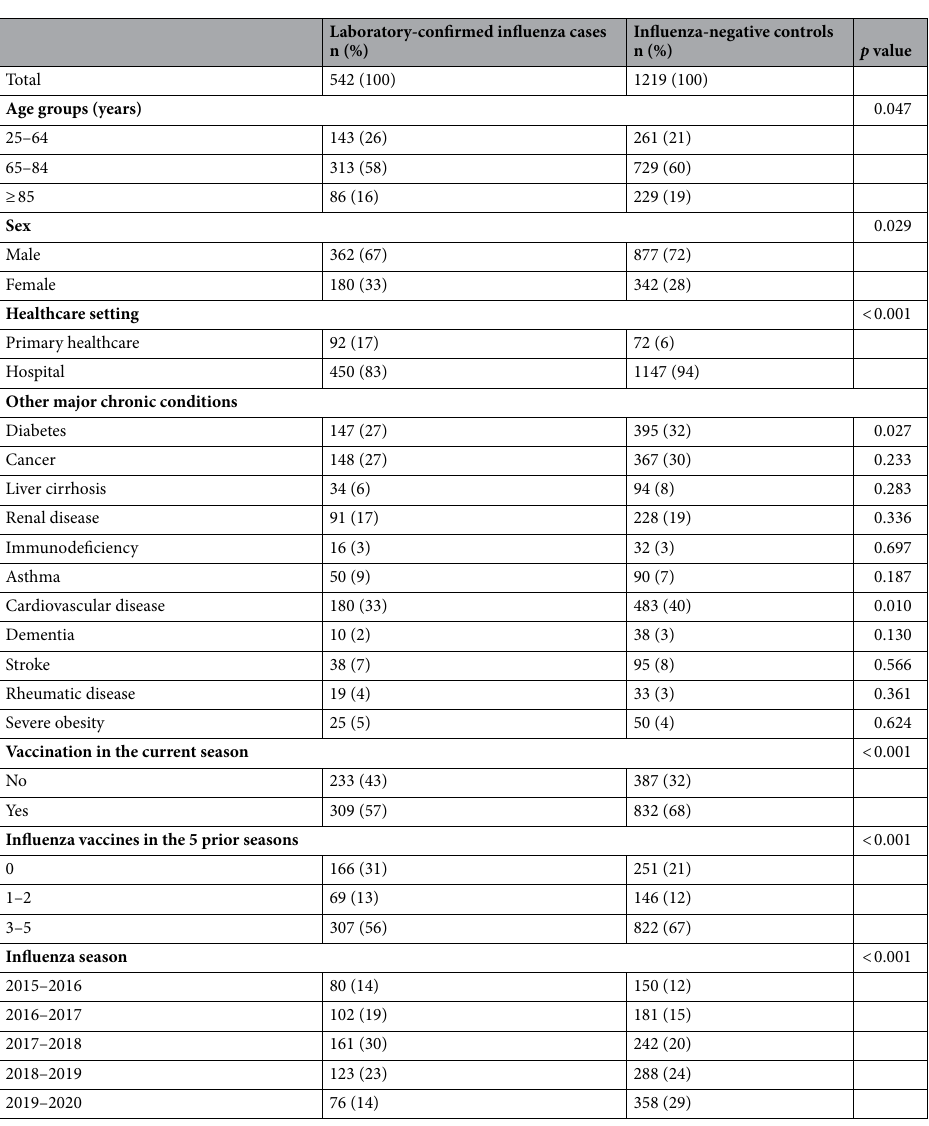
Table 1. Baseline characteristics of individuals with chronic obstructive pulmonary disease consulting or hospitalized for influenza-like illness according to the result of the influenza